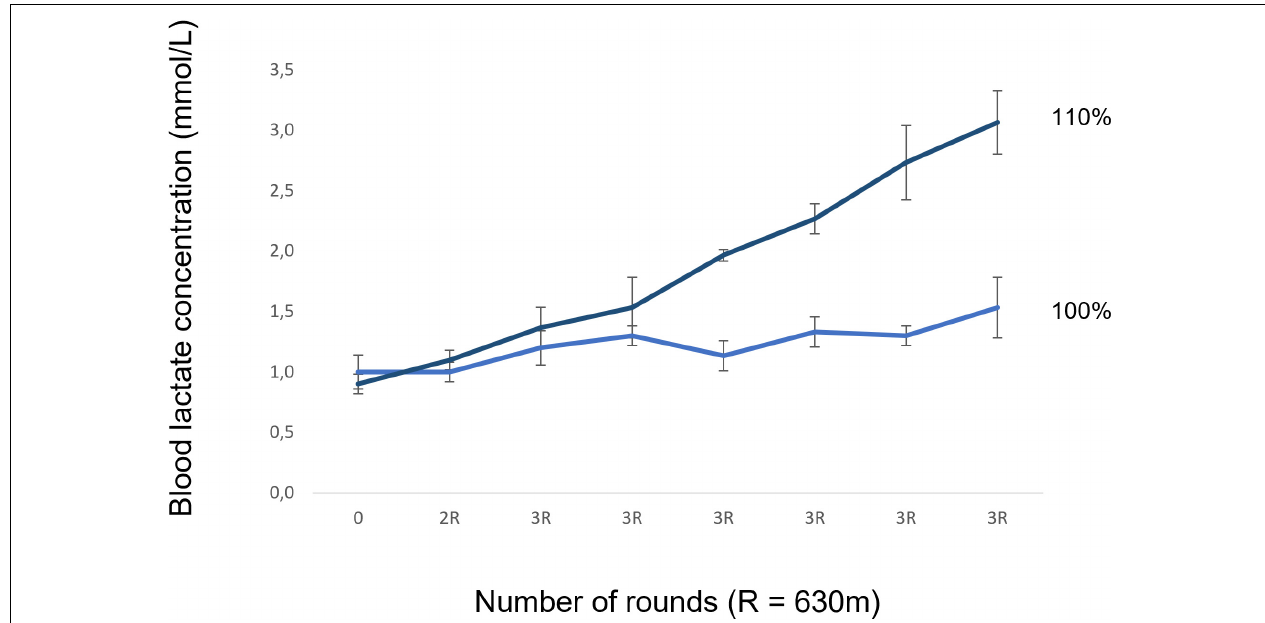
FIGURE 5 | Validation of the LMS test at speeds of respectively 100% LMS and 110% LMS. No blood lactate increase ( > 1 mmol/L) occurred during validation at 100% LMS; however, it did so at 110% LMS for most of the